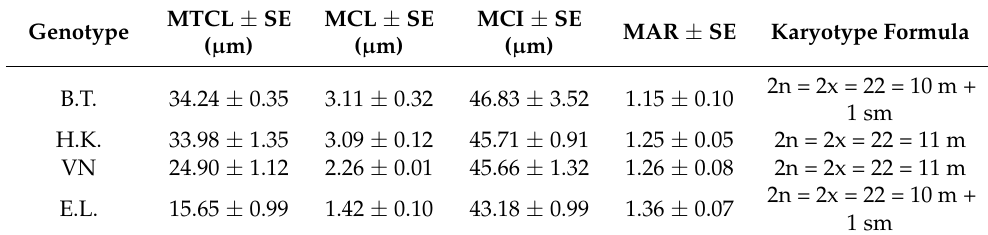
Table 2. Variations in the karyotype features in examined Phaseolus vulgaris L. genotypes.